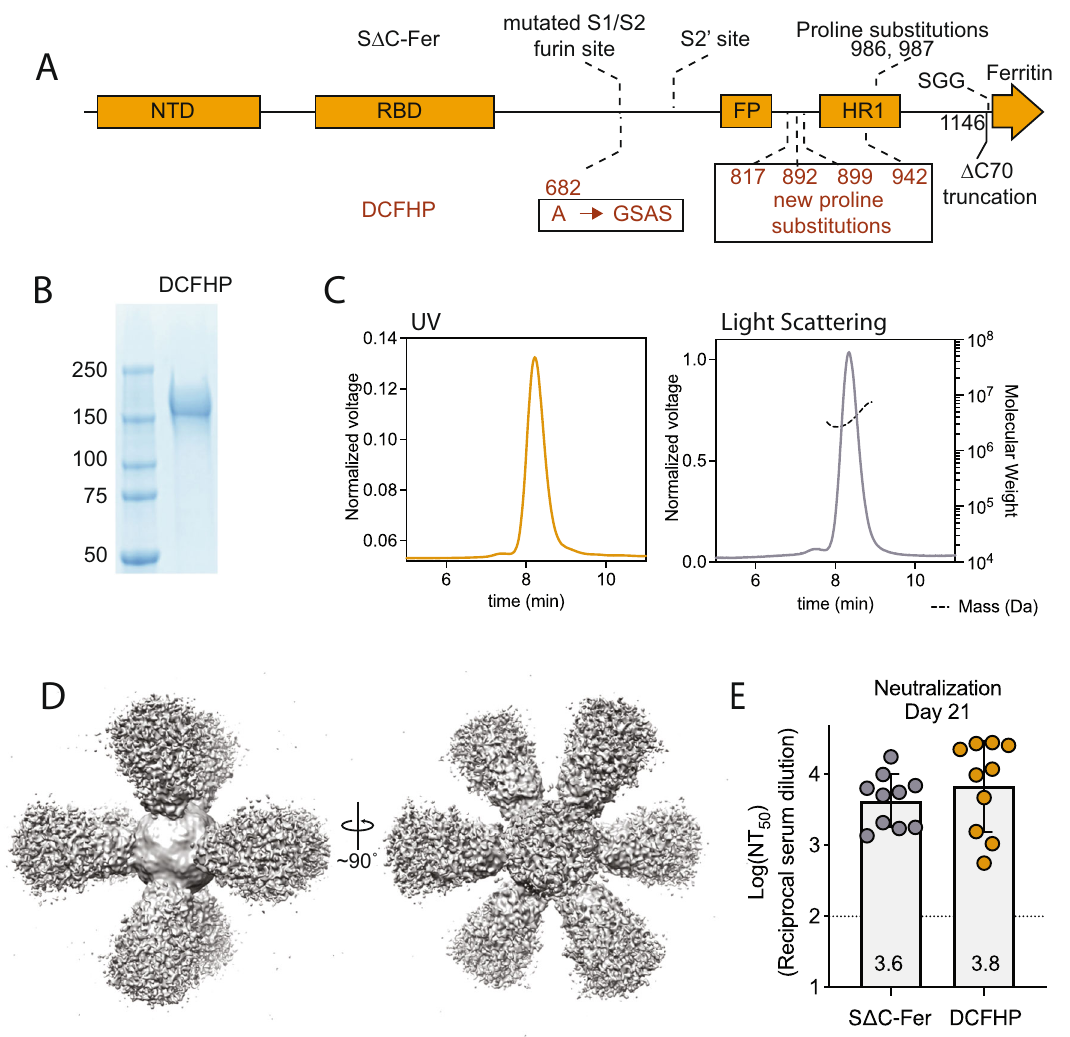
Fig. 1 | DCFHP design and validation. A DCFHP schematic showing the mod- i fi cations made to convert S Δ C-Fer into DCFHP in red. Receptor binding domain (RBD), N-terminal domain (NTD), S1/S2 cleavage site, S2 ’ cleavage site, fusion peptide(FP),heptadrepeat1(HR1),asannotated. B SDS-PAGEgelshowingpuri fi ed DCFHP running as a monomer at the anticipated kDa molecular weight (ladder, shownleft).The gelisrepresentative ofthe numerous DCFHP samples runbySDS- PAGE. C UV (yellow) and light scattering (gray) traces determined from SEC-MALS shows a homogenous nanoparticle peak with approximate molecular weight